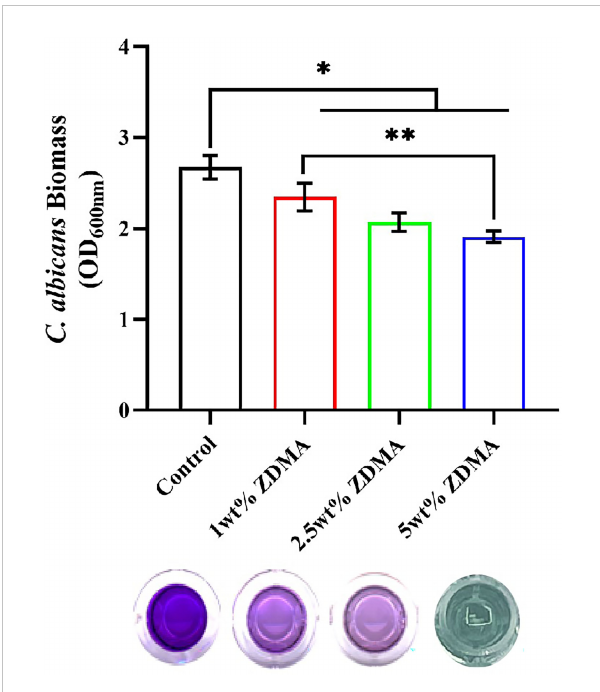
FIGURE 7 The visualization of C. albicans bio fi lm formation and means ± standard deviations for C. albicans biomass accumulation of the specimens for each group (*p < 0.05, **p < 0.01).